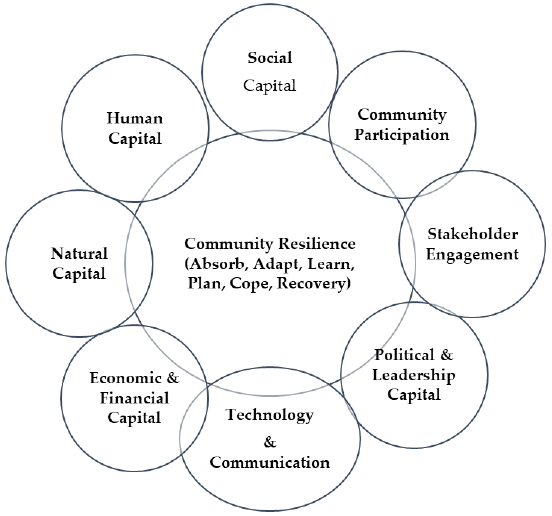
Figure 1. Factors of community resilience.